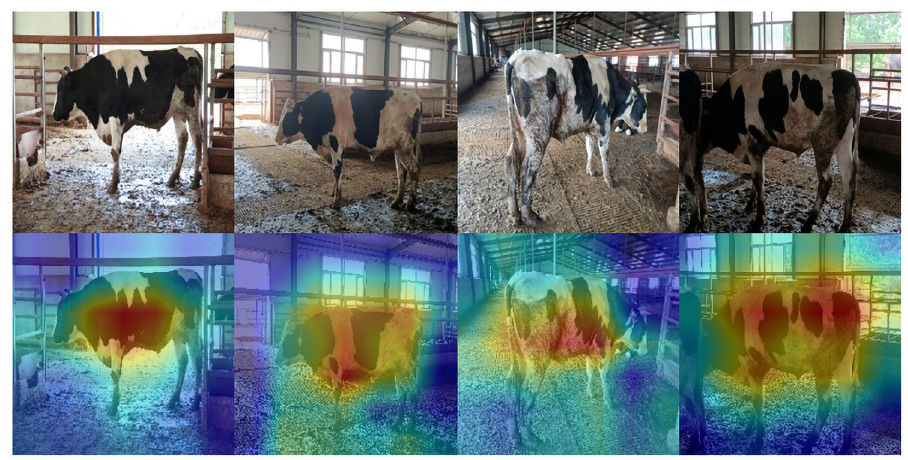
Fig 11. Example cow heat